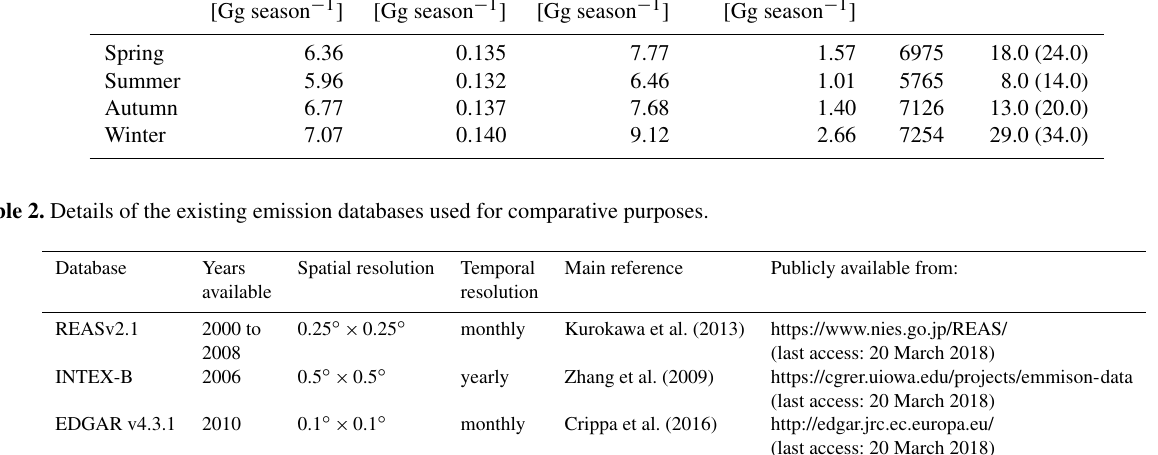
Table 1. The average SO 2 emission levels over China for the four seasons of the year 2010 as presented in Fig. 5. A priori A priori error